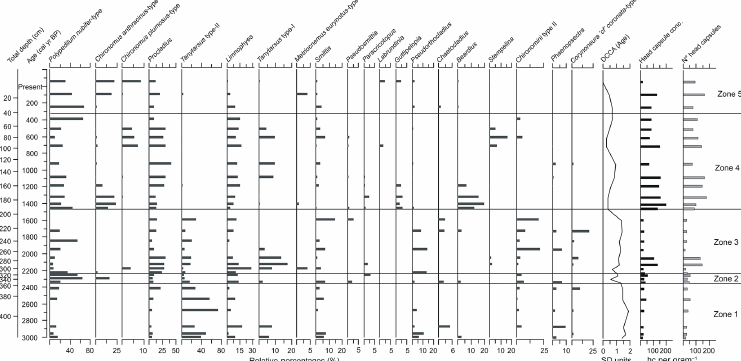
Figure 7. Diagram of fossil chironomid assemblage of Laguna Pindo. Five significant zones were identified using optimal partitioning with a broken-stick model. Detrended canonical correspondence analysis (DCCA) constrained by calibrated radiocarbon age shows taxon turnover through time. Only taxa with relative abundances greater than 5% are shown. SD: standard deviation; hcgram − 1 : head capsules per gram of wet sediment.